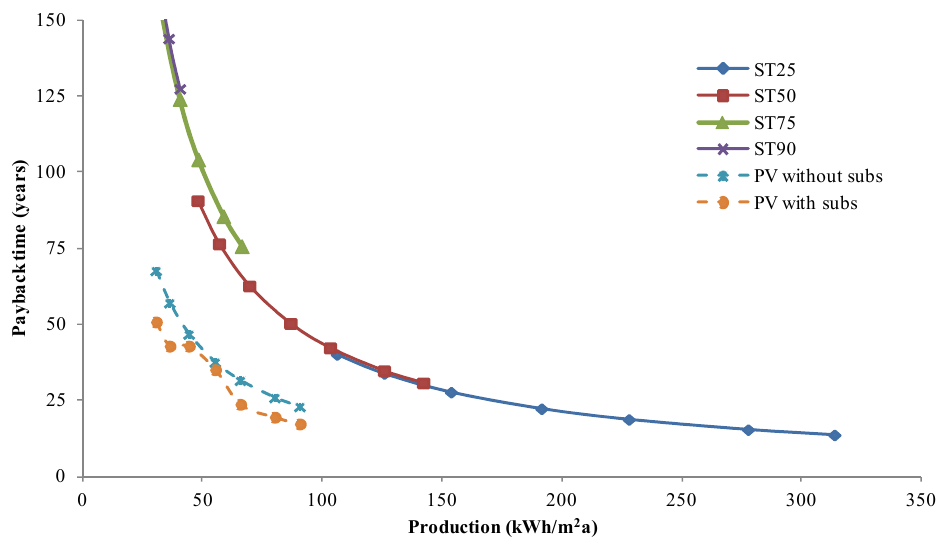
Figure 9. Payback time vs.